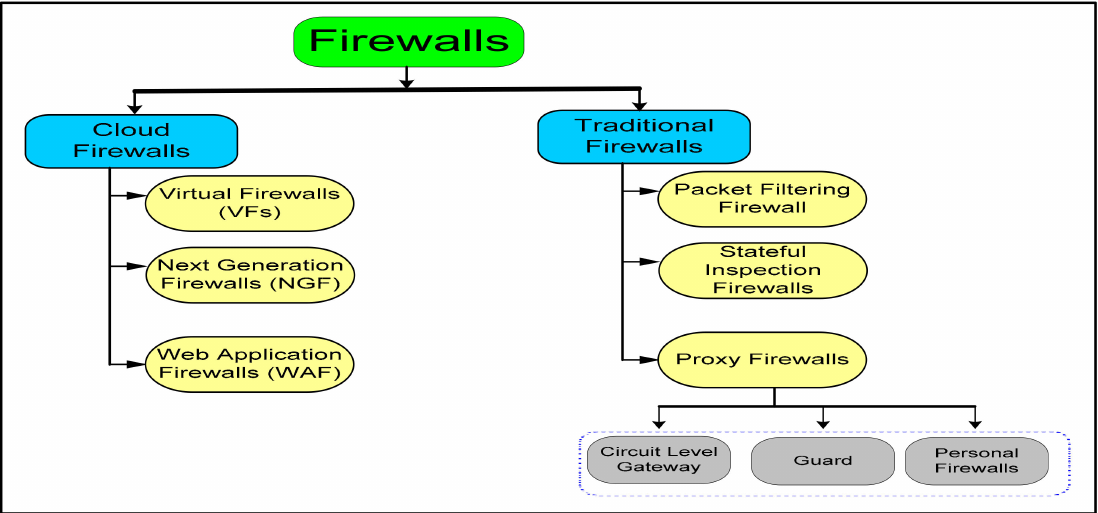
Figure 3. Taxonomy diagram of firewalls (micro